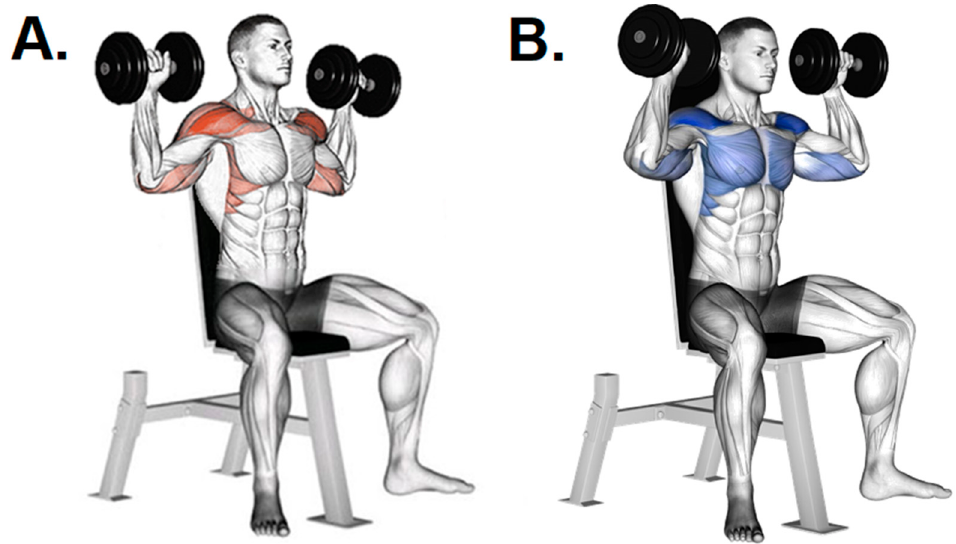
Figure 5. Representation of the “high-five” position: ( A ) traditional technique requiring a “high-five” end-position range (upper arm in 90 ◦ abduction, elbow in 90 ◦ flexion, and terminal external rotation of the shoulder), where the risk of injury increases with the anterior instability; ( B ) modification to avoid the “high-five” end-position. Raising the arms slightly in front of the head without extending completely in military press is advisable to decrease injury or pain risk. Source: taken from Gym Visual available at https://gymvisual.com/ under copyright and owned by Aliaksandr Makatserchyk. Accessed on 14 January 2022.